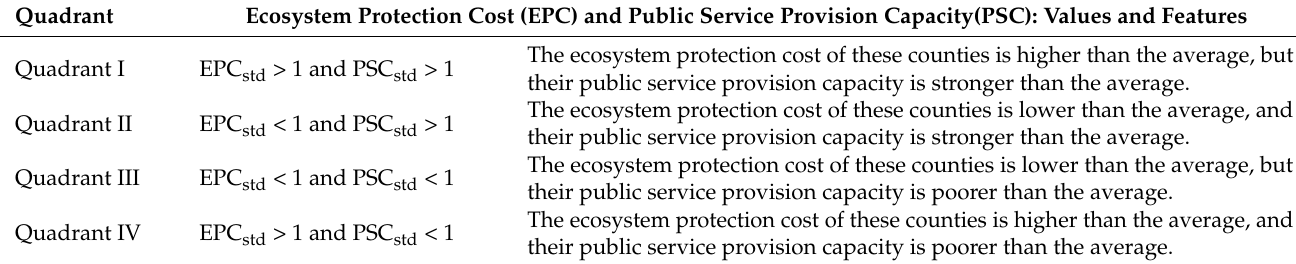
Table 4. Quadrant analysis for National Key Ecological Function County categorization.